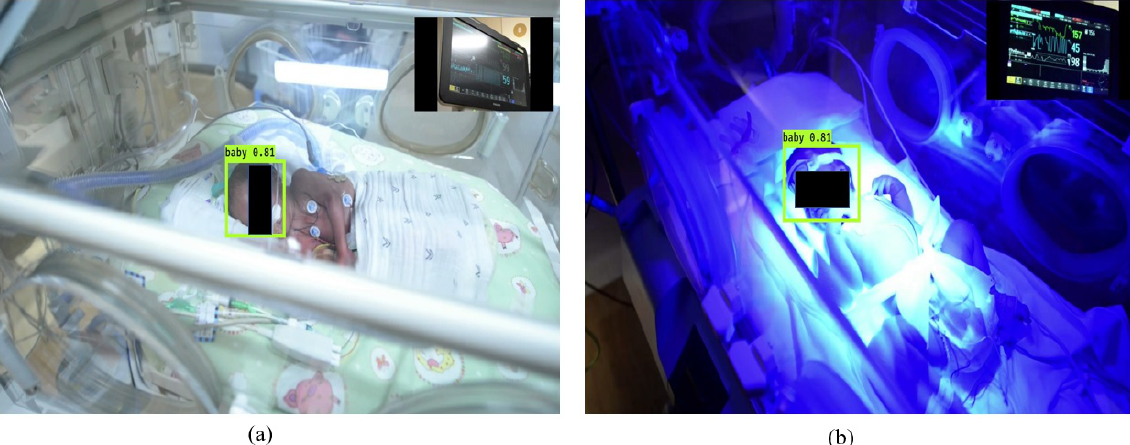
Figure 4. Automatic ROI selection using the YOLO neural network. The detected ROIs were shown in green bounding boxes. ( a ) Infant under normal light, ( b ) infant under blue light.